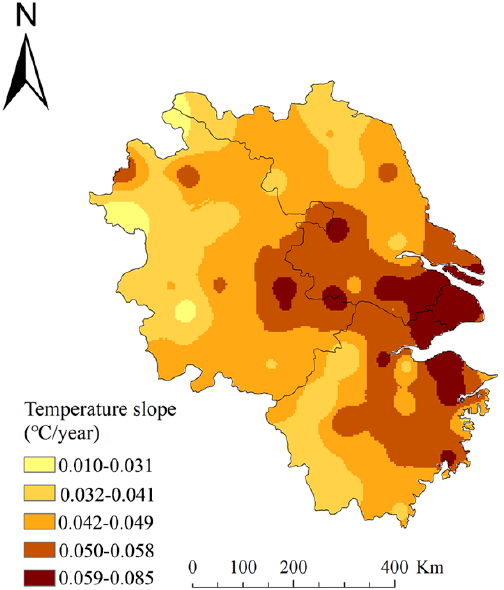
Figure 6. Temperature slope (change rate of temperature) during the period of 1980–2012.